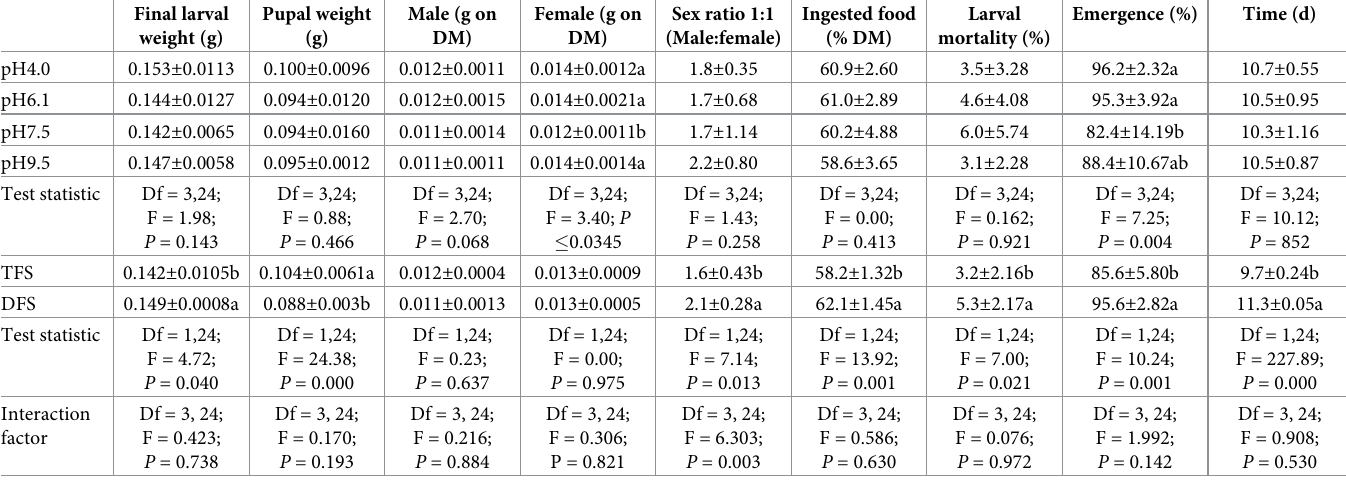
Table 1. Life history traits of the larvae and adults of BSF reared on diets with different pH (pH4.0; pH6.1; pH7.5; pH9.5) and with different feeding systems (TFS: Total amount of diet provided at the beginning (480g on WB); DFS: Daily allocated diet (40g/d on WB)). Mean ±SD. DM: dry matter. Different letters within a col- umn (life history trait) indicate significant difference for P (cid:20) 0.05.